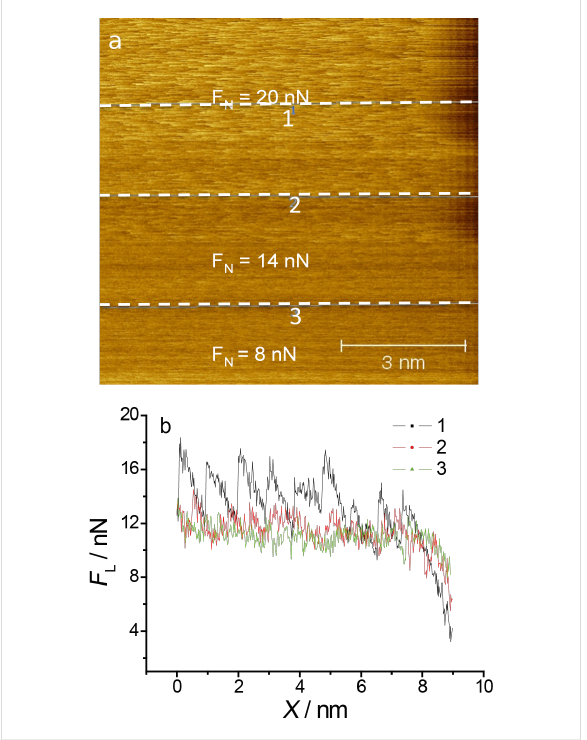
Figure 10: Transition from irregular to regular stick–slip on a copper monolayer a) AFM image at three different normal loads; b) cross sections along the lines from image a). E = 10 mV; scan rate 213